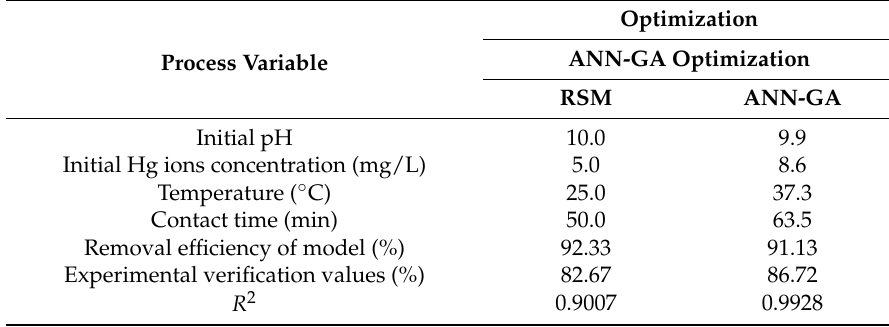
Table 1. Comparative results for optimization by artificial neural networks-genetic algorithm (ANN-GA) and response surface methodology